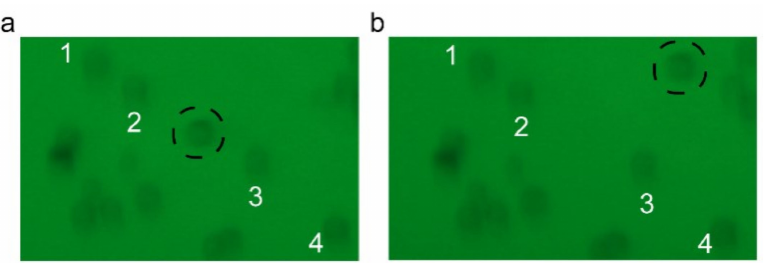
Figure 12. Trapping process of single vaterite particle. ( a ) Before trapping; ( b ) After trapping (Particles 1–4 are reference